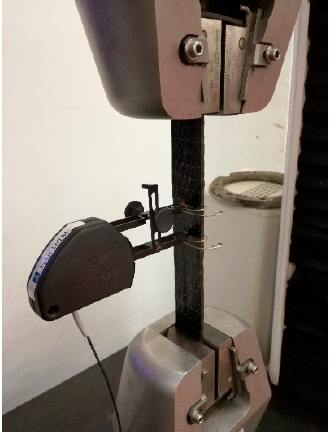
Figure 3. Tensile test setup .